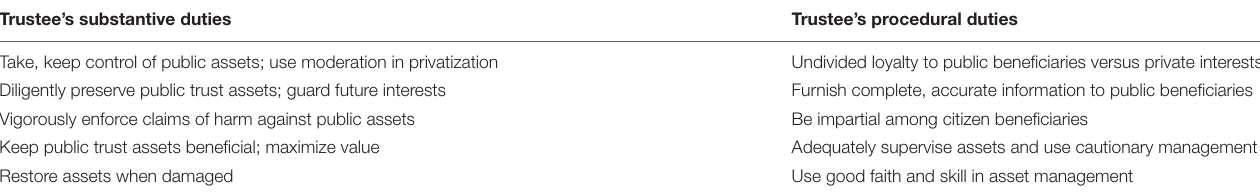
TABLE 1 | Public Trust Governmental Duties of